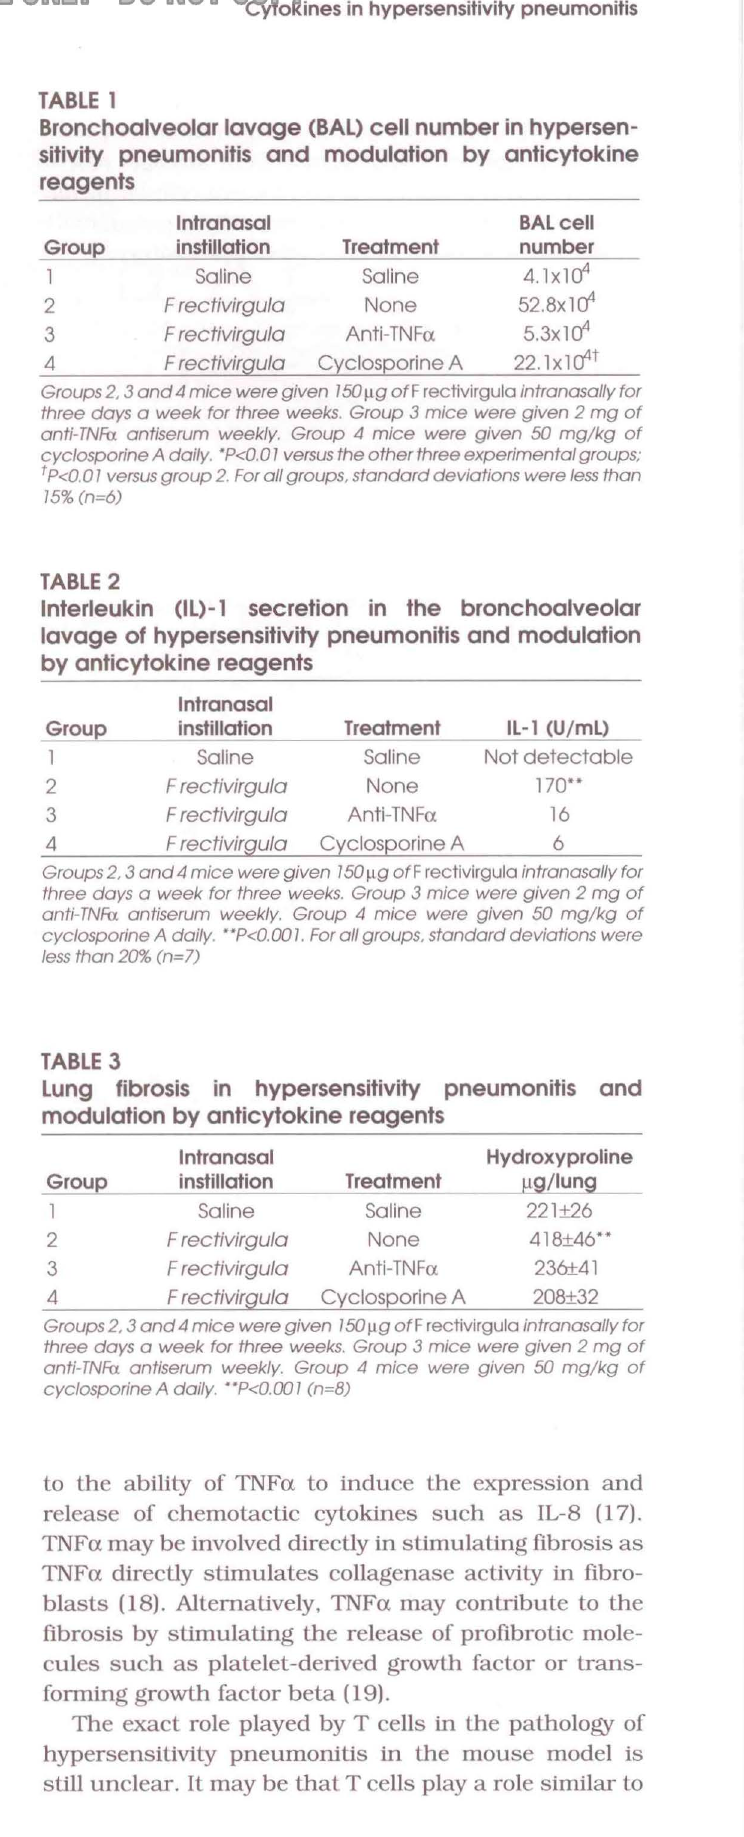
Bronchoalveolar lavage (BAL) cell number in hypersen sitivity pneumonitis and modulation by anticytokine